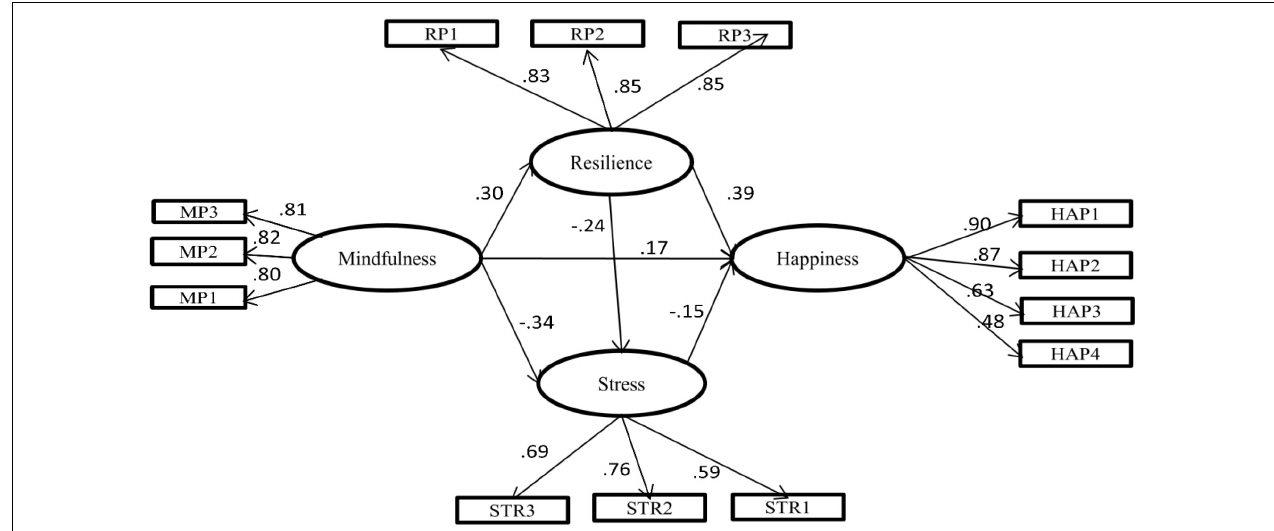
FIGURE 1 | The Structural Equation Model regarding the mediating effect of resilience in the relationship of mindfulness to happiness, and stress. Factor loadings are standardized. MP1–MP3 = three parcels of mindfulness; RP1–RP3 = three parcels of resilience; STR1-STR3 = three parcels of stress.